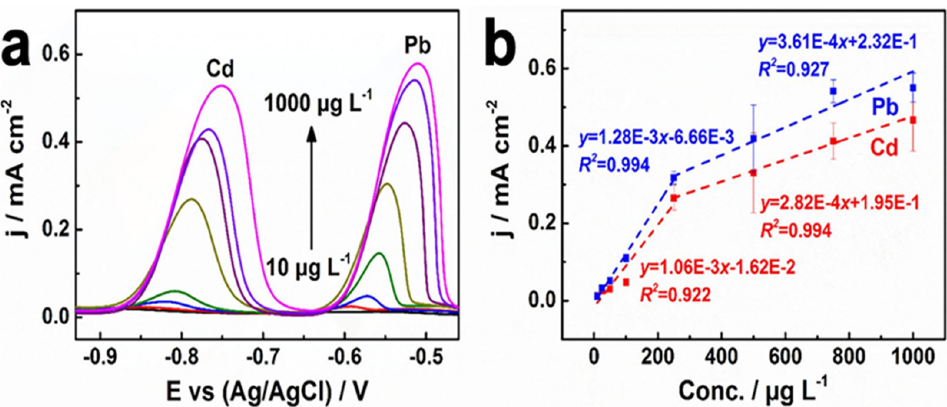
Figure 5. ( a ) Differential pulse anodic stripping voltammograms and ( b ) corresponding calibration plots for simultaneous determination of Cd 2+ and Pb 2+ with concentrations of 10, 25, 50, 100, 250, 500, 750, and 1000 µg L − 1 on D/CNWs—3% electrode. Error bar: n = 3 (reproduced with the permission of [77]).